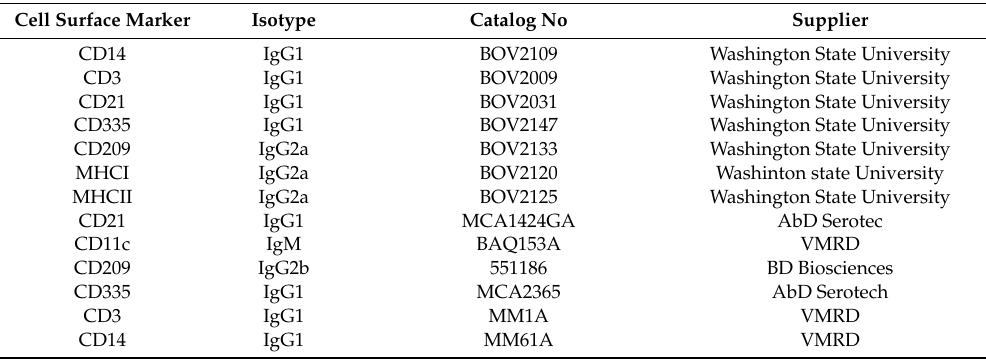
Table 1. Monoclonal antibodies (MAbs) used to detect bovine leukocyte